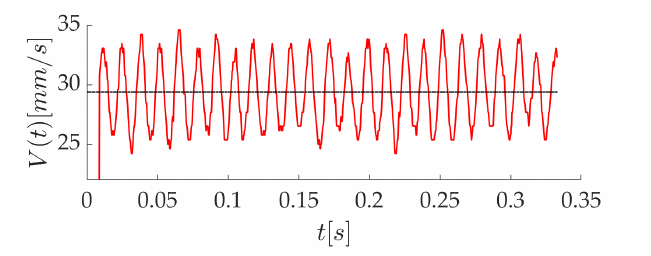
Figure 6. Time evolution of the printing head